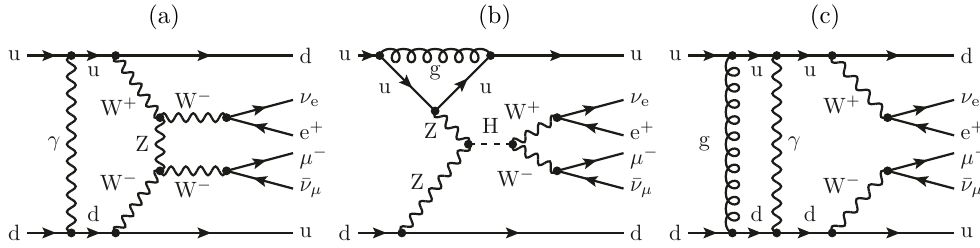
(cid:0) (cid:1) (cid:0) (cid:1) g 8 and g 2 g 6 . The first one (a) is a pure EW s O O